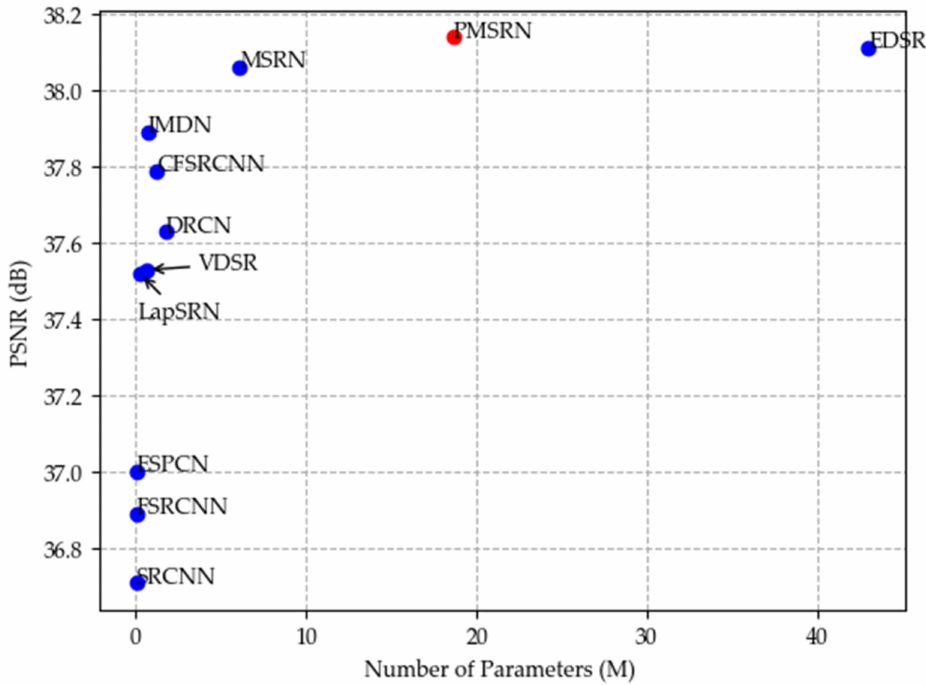
Figure 10. Comparison of our method with the state-of-the-art models when applied to Set5 (2 × , r = 2) with respect to PSNR and the number of parameters (‘M’ represents the number of parameters in